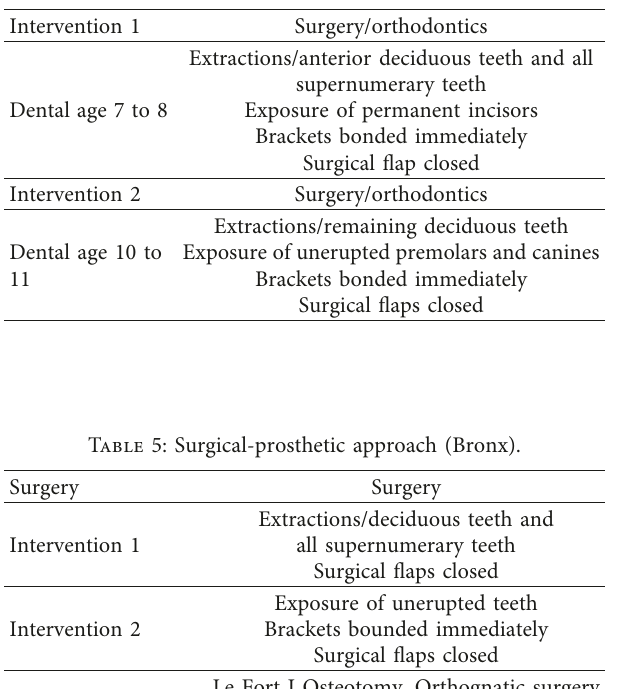
Table 4: Two surgery approach (Jerusalem).